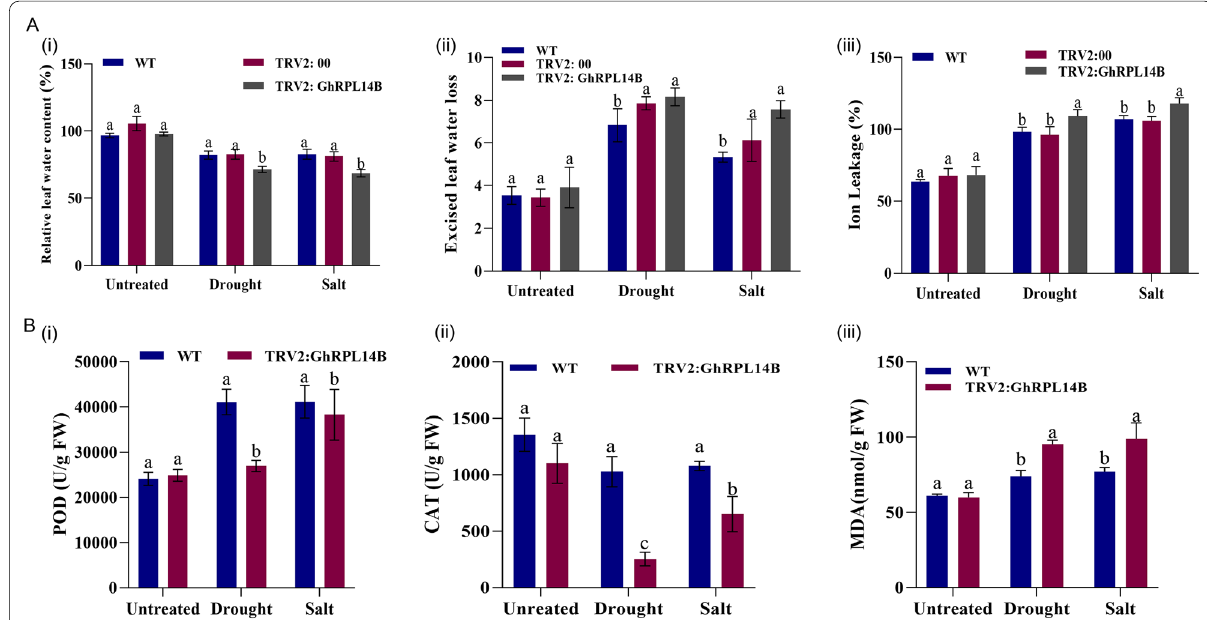
Fig. 9 Physiological analysis and Biochemical assays of the oxidant and antioxidant in VIGS plants under drought and salt stress conditions. A (i) Quantitative determination of relative leaf water content (RLWC), (ii) excised leaf water loss (ELWL), and (iii) Quantitative determination of ion leakage as a measure of cell membrane stability (CMS). B Biochemical analysis (i) Quantitative determination of peroxidase (POD), (ii) Quantitative determination of catalase (CAT), and (iii) quantitative determination of Malondialdehyde (MDA). The bar indicates a standard error (SE). Different letters indicate the significant differences between the wild type and the VIGS-plants (ANOVA; P <